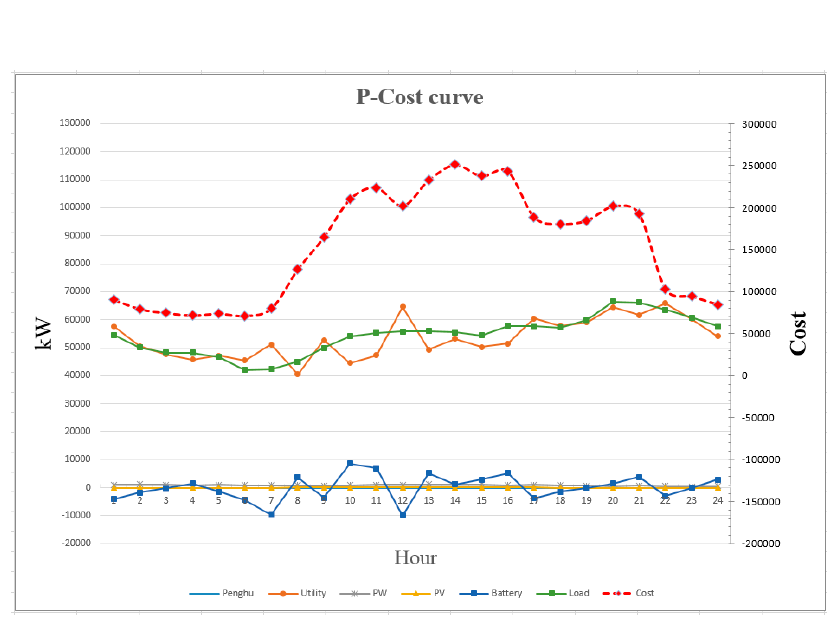
Figure 11. Generation supply scheme and dispatch cost at the 95% confidence level.